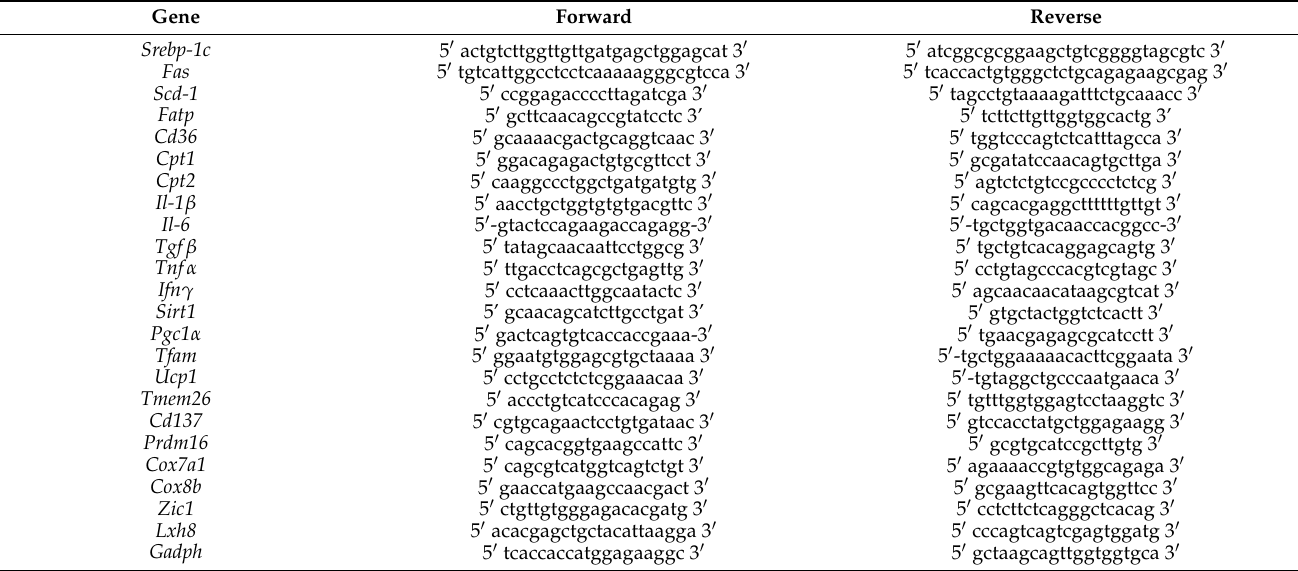
Table 1. The primers sequence for